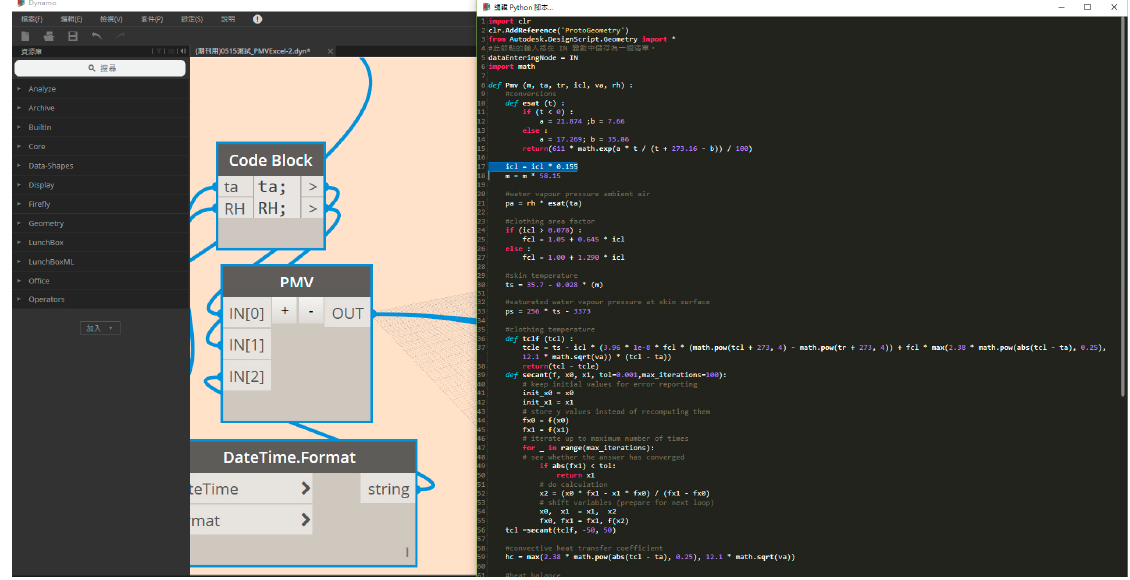
Figure 12. Creating a PMV formula module in Dynamo.